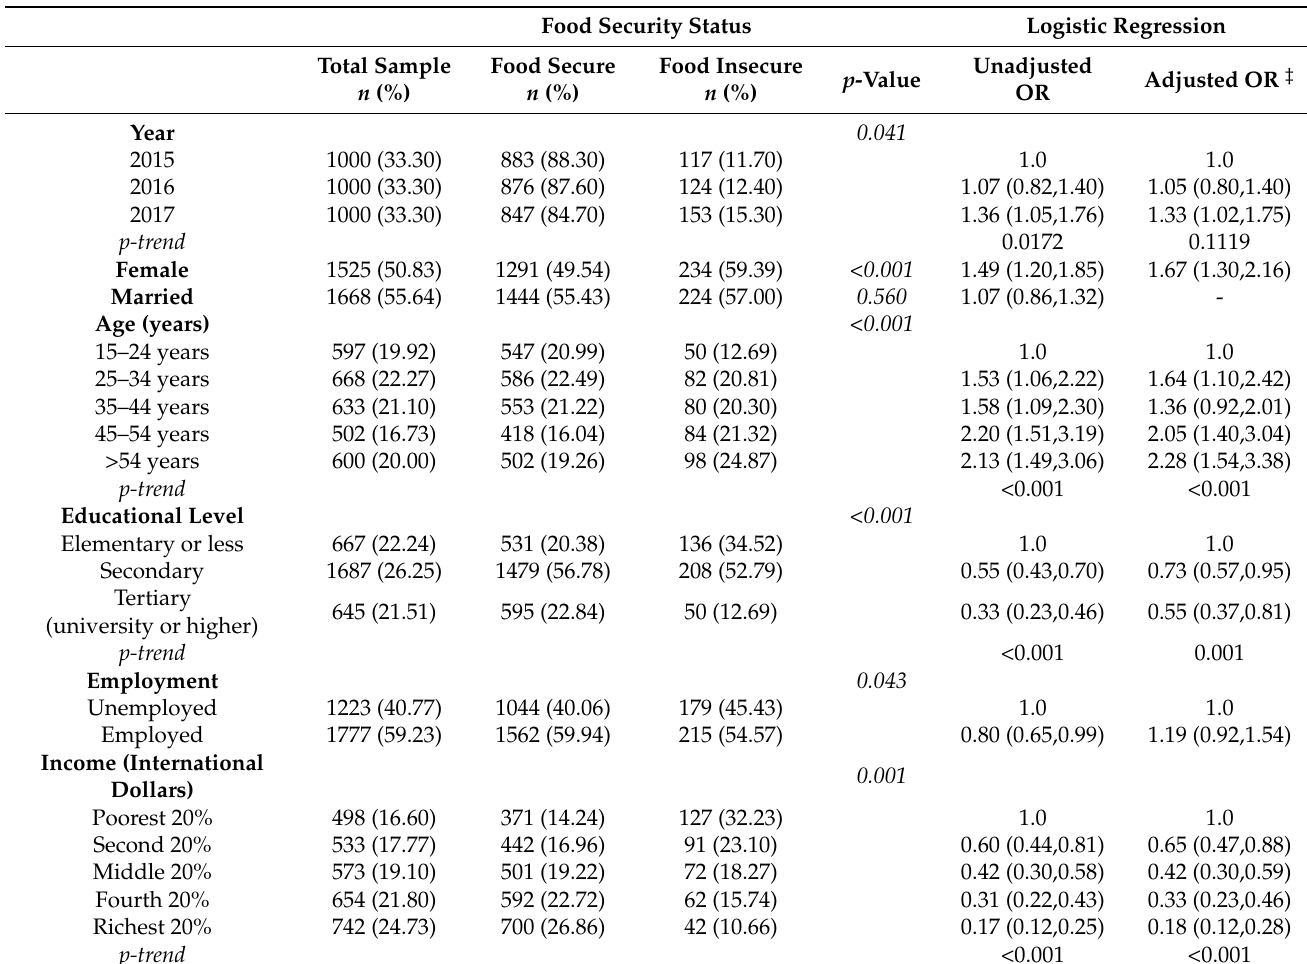
Table 1. Associations between the sociodemographic and economic characteristics of the study population and FI in Lebanon using GWP data (2015–2017) †